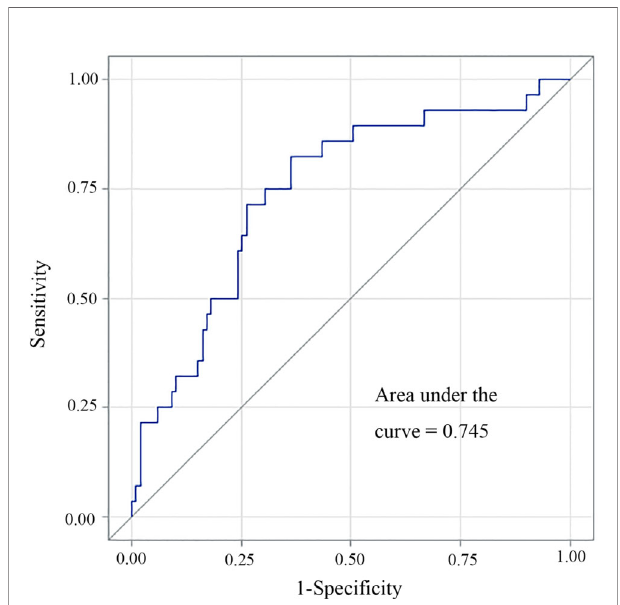
FIGURE 4 | An external cohort veri fi cation of the prediction model for DLN metastasis.